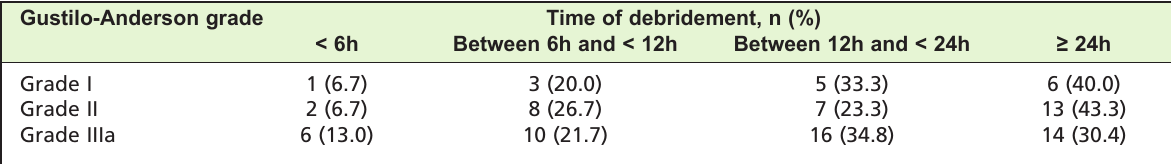
Table II: Gustilo-Anderson grade and time of debridement